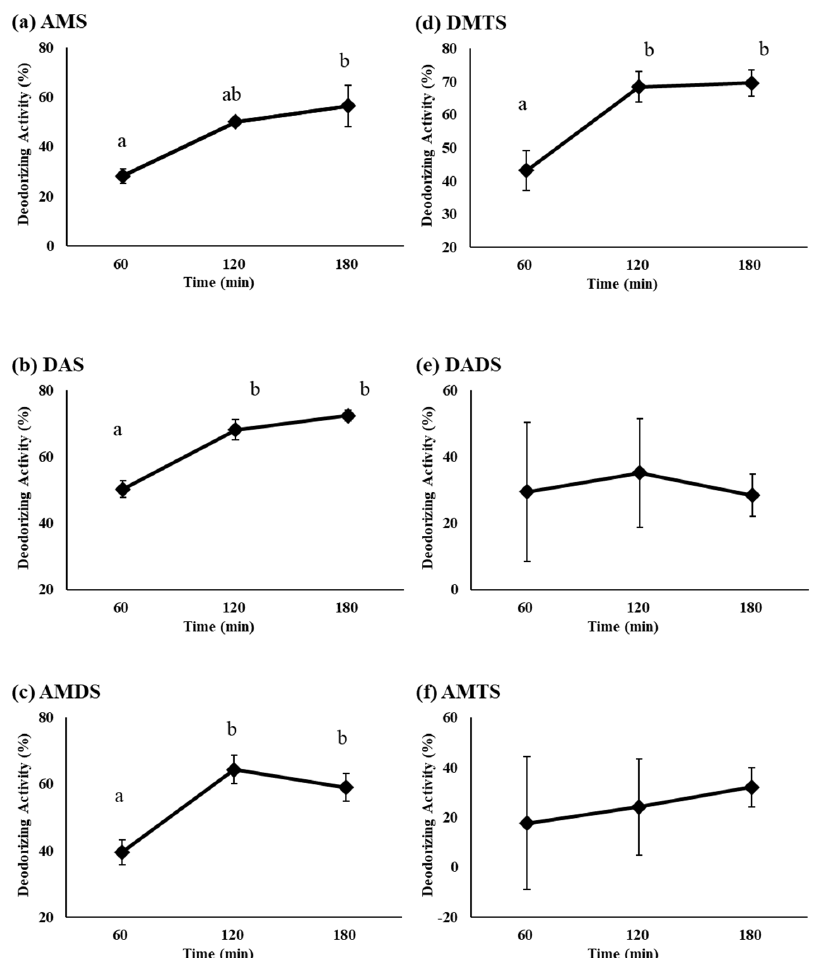
Figure 3. Deodorant activity of BCO against organosulfur compounds in GEO at pH 1.2: ( a ) AMS, ( b ) DAS, ( c ) AMDS, ( d ) DMTS, ( e ) DADS and ( f ) AMTS. Dosage of BCO, 10 mg, dosage of GEO, 15 µ g. Values were shown as means with standard error as error bars ( n = 3) with different letters to show significant differences ( p <